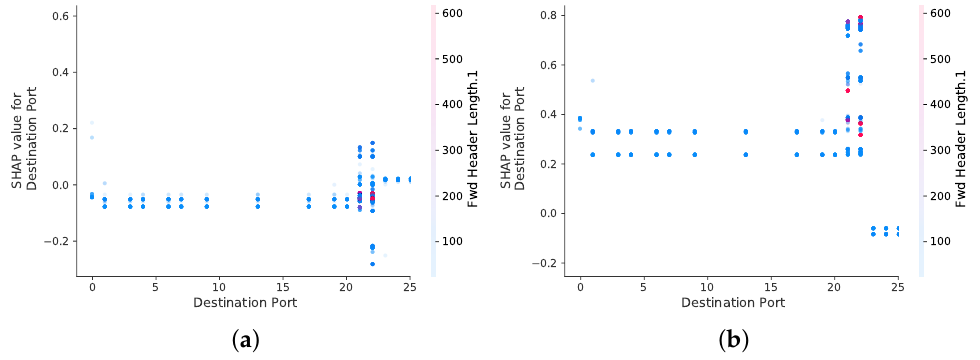
Figure 8. Fwd Header Length.1/Destination Port interaction plots. ( a ) Fwd Header Length.1/ Destination Port interaction for port scan attacks; ( b ) Fwd Header Length.1/Destination Port interaction for brute force attacks.